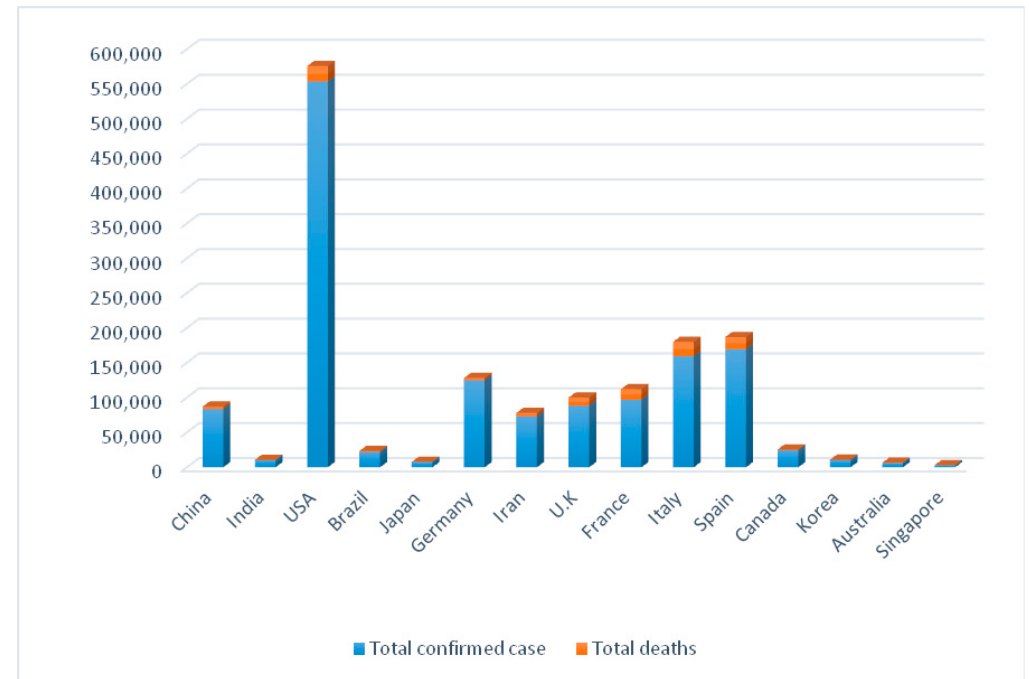
Figure 1. Comparison between total deaths and confirmed cases in some countries with different